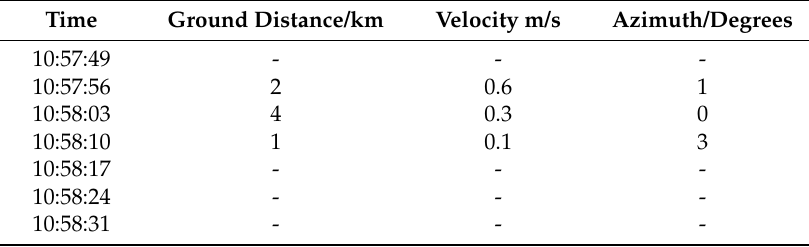
Table 3. The absolute value of the difference between two tracks’ tracking